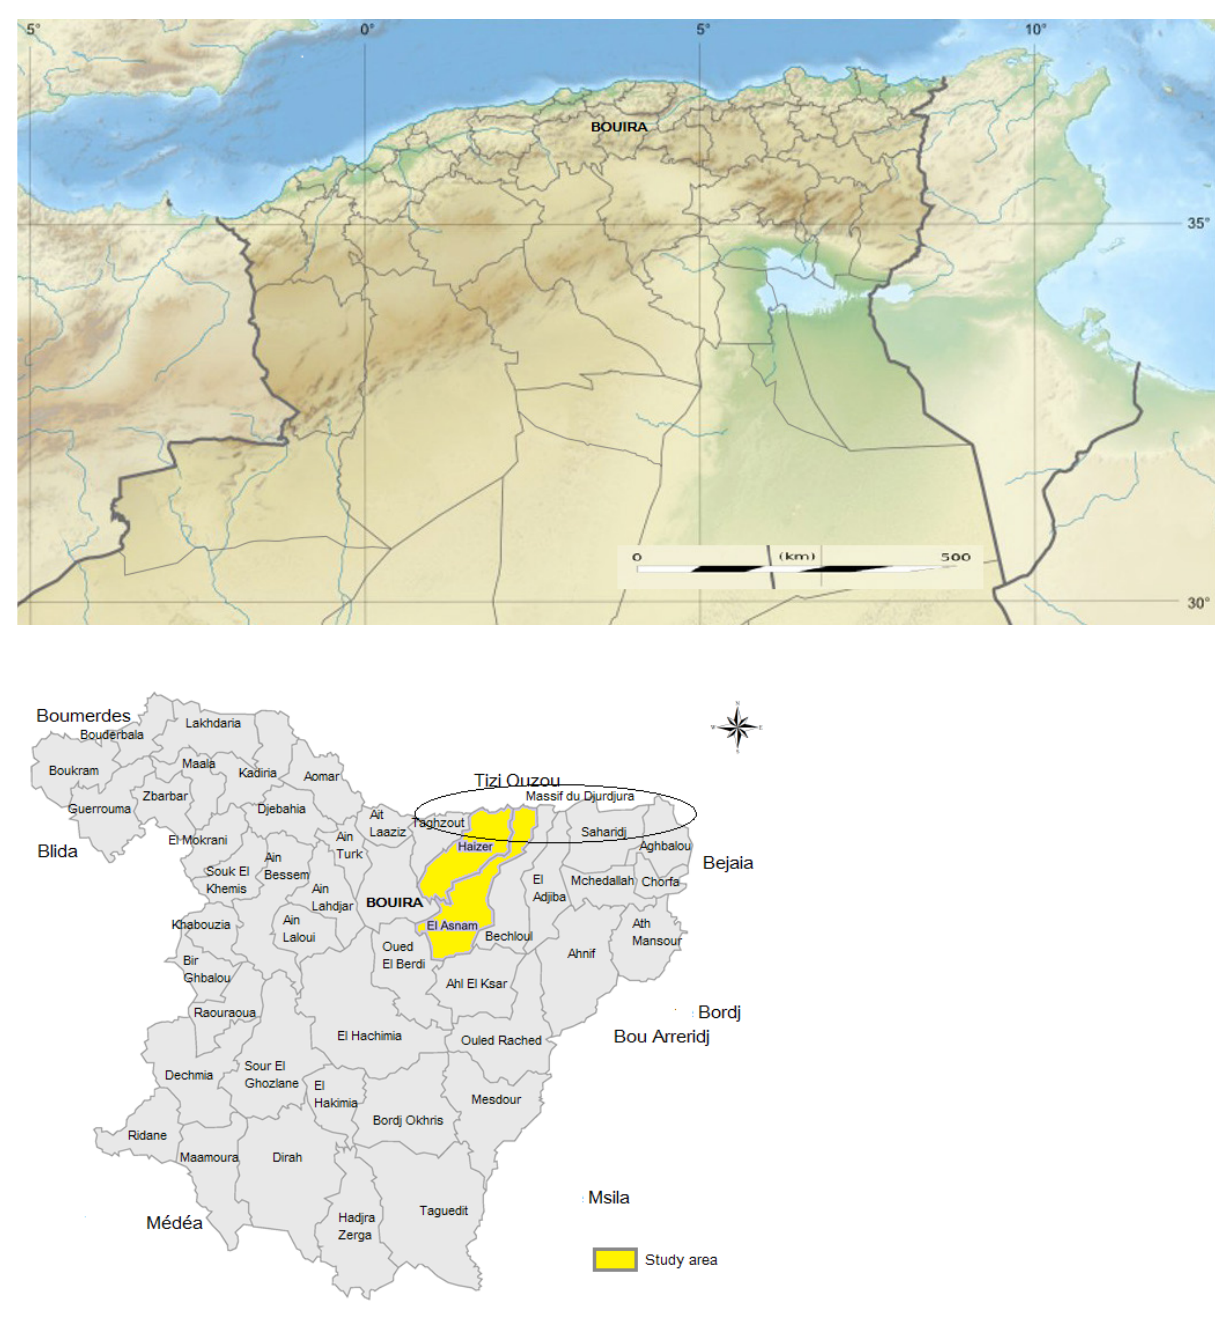
Figure 1. Location of the study area: municipalities of Haizer and El Asnam, Bouira province (Anon., 2013).